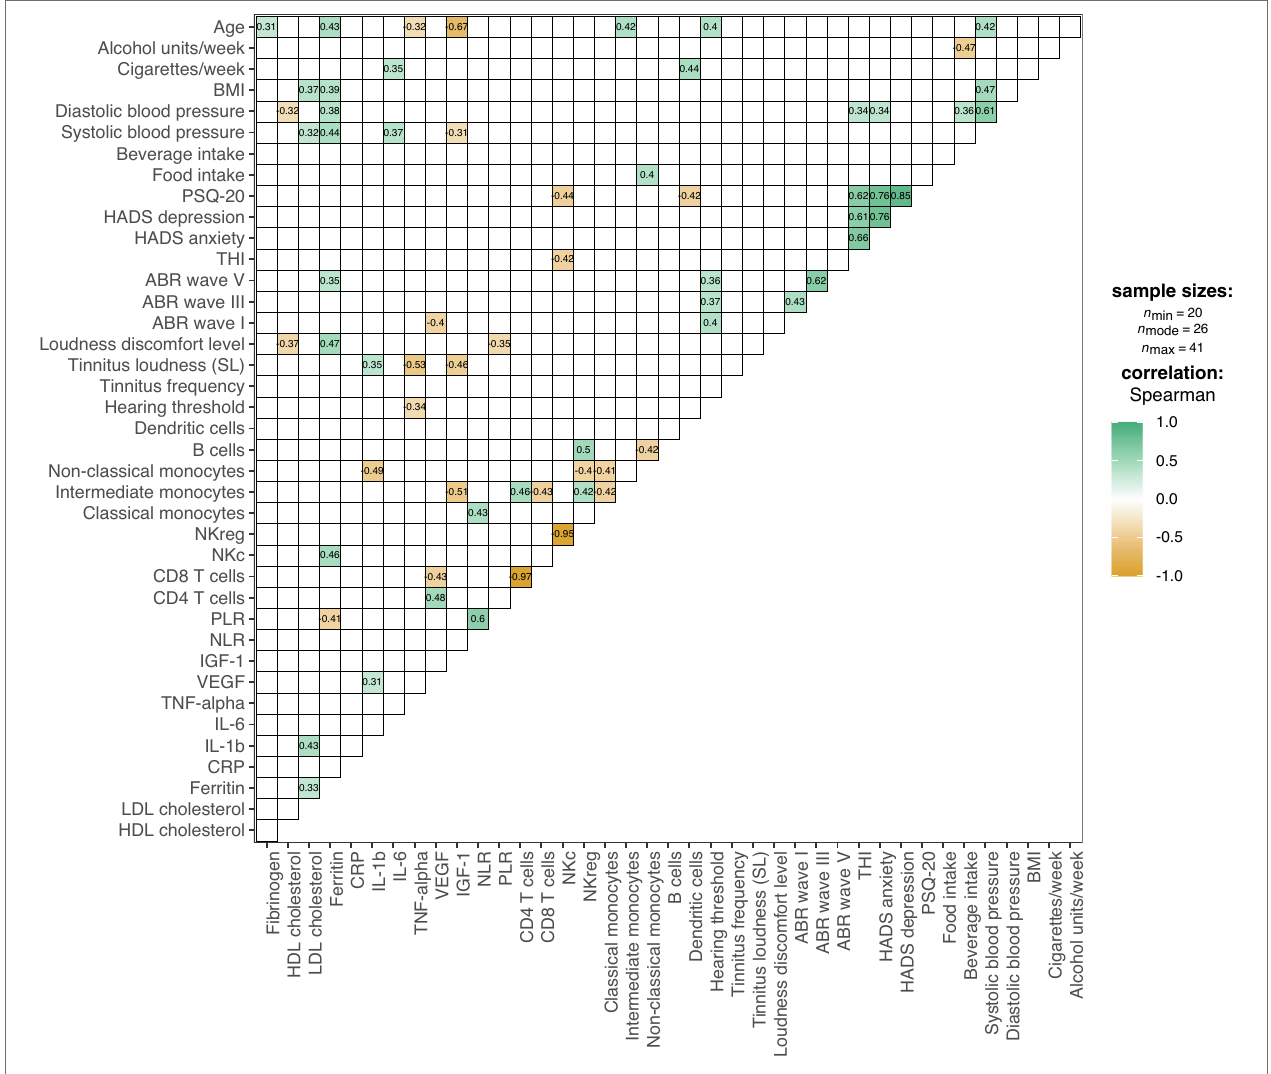
FIGURE 2 | Correlation plot for the associations between lifestyle, psychological, audiological factors, immune cell subsets, and other blood parameters. Colors represent the direction and degree of significant pairwise correlations (Spearman); positive correlations are shown in green and negative correlations in orange; non- significant correlations ( p > 0.05) are omitted. ABR, Auditory Brainstem Response; BMI, Body-Mass-Index; CRP, C-Reactive Protein; HADS, Hospital Anxiety and Depression Scale; HDL, High-Density Lipoprotein; IGF-1, Insulin-Like Growth Factor-I; IL, Interleukin; LDL, Low-Density Lipoprotein; NKc, Cytotoxic Natural Killer Cells; NKreg, Regulatory Natural Killer Cells; NLR, Neutrophil-to-Lymphocyte Ratio; PLR, Platelet-to-Lymphocyte Ratio; PSQ-20, Perceived Stress Questionnaire (20-item version); SL, Sensation Level; THI, Tinnitus Handicap Inventory; TNF-alpha, Tumor Necrosis Factor-alpha; VEGF-A, Vascular Endothelial Growth Factor